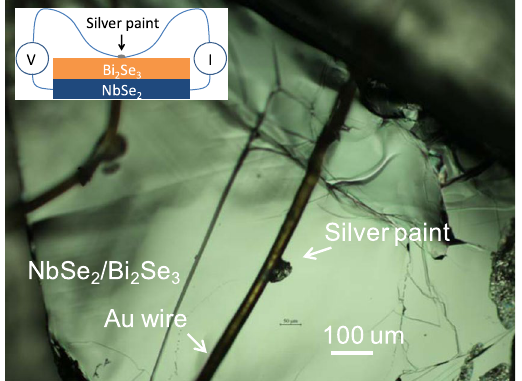
Figure 1. Point contacts on NbSe 2 /Bi 2 Se 3 heterostructure. An optical microscopic picture showing two silver paint point contacts on a NbSe 2 /Bi 2 Se 3 heterostructure sample. The Au wire diameter is 25 um. The size of the silver paint contacts is ~50 um. A schematic of the point contact spectroscopy measurement of the bilayer sample is shown in the